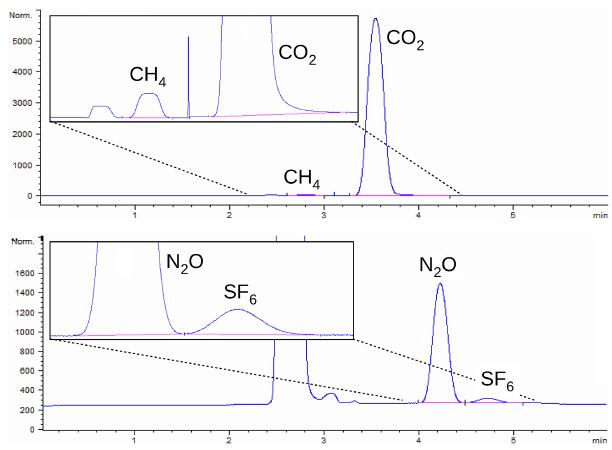
Figure 3. Typical chromatograms obtained by the FID (top panel) and by the µ ECD (bottom